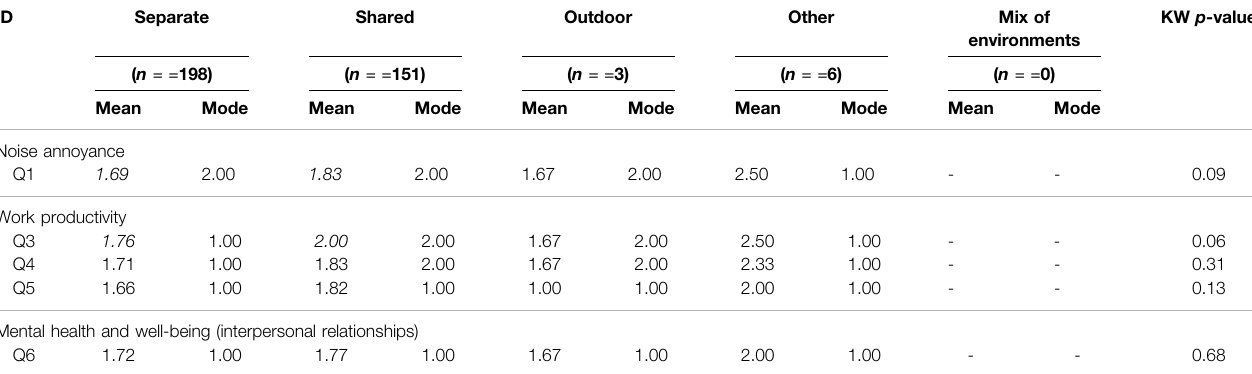
TABLE 3 | Mean and mode values of the answers given by nonsensitive ( n (cid:1) (cid:1) 358) to noise respondents on noise annoyance (Q1), work productivity (Q3, Q4, Q5), and mental health and well-being (Q6) for different typologies of remote working environments, considering. Two-tailed p -values of signi fi cance for the differences between acrossenvironmentsarereportedaccordingtotheKruskalWallis(KW)Test.Speci fi csigni fi cantdifferences( p -value < 0.10)betweenenvironmentsaregivenasmeanvalues in italics as a result of the application of the Mann Whitney U